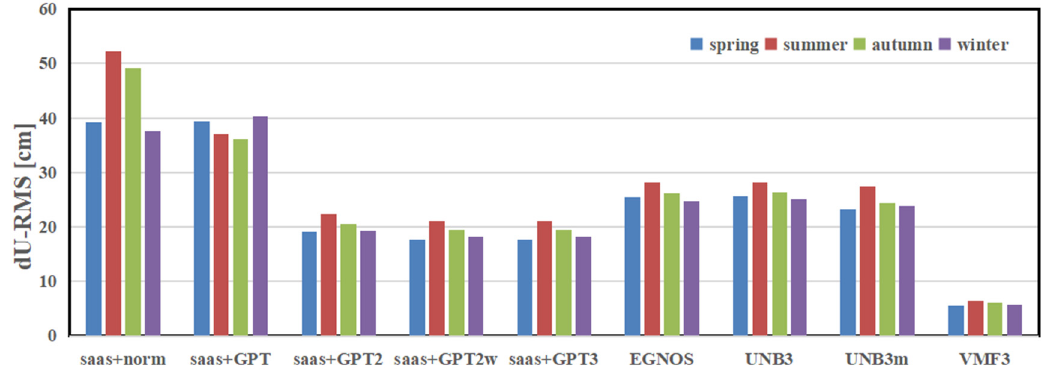
Figure 6. RMSs of the SPP solutions on the vertical direction produced by dZTD of the 9 models (saas+norm/GPT/GPT2/GPT2w/GPT3, EGNOS, UNB3, UNB3m, VMF3) in different seasons. To compare the model discrepancies in different geographical locations, the dZTD RMSs (upper panels) and RMSs of the SPP biases on the vertical direction (lower panels) generated by dZTD from saas+GPT (left panels) and UNB3 (right panels) models at globally distributed IGS stations are shown in Figure 7. Triangulation linear interpolation is used for the demonstration. One can see that the saas+GPT model performs worst around the equator, and best around middle latitude areas. Near the equator, the dZTD RMSs can exceed 20 cm and accordingly cause over 100 cm biases on the SPP solutions in the vertical direction. In contrast, more significant asymmetry between southern and northern hemispheres is observed by using the UNB3 model. The performance of UNB3 model is significantly better in the northern hemisphere, especially around middle and high latitudes (40 ◦ N~90 ◦ N), where the dZTD RMSs are below 5 cm and RMSs of SPP vertical biases are below 20 cm.